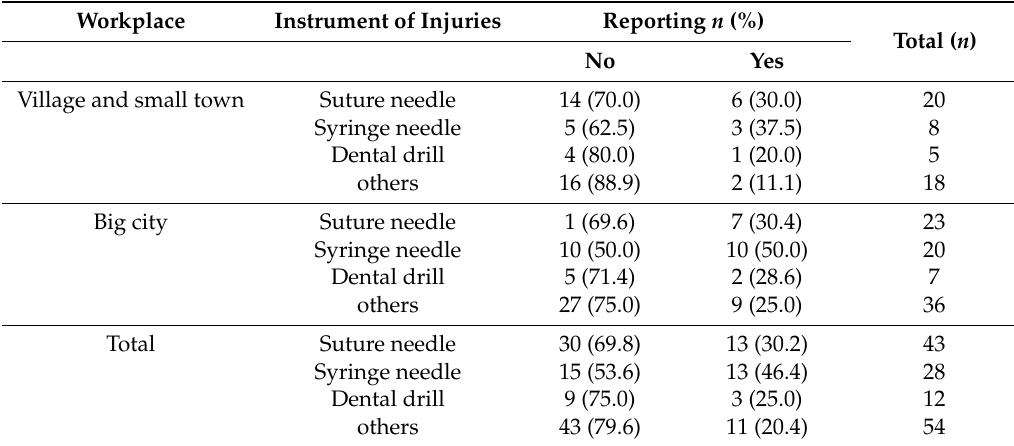
Table 4. The structure of injury reports depending on the type of tool and the dentist’s workplace, N = 137 injuries and n = 40